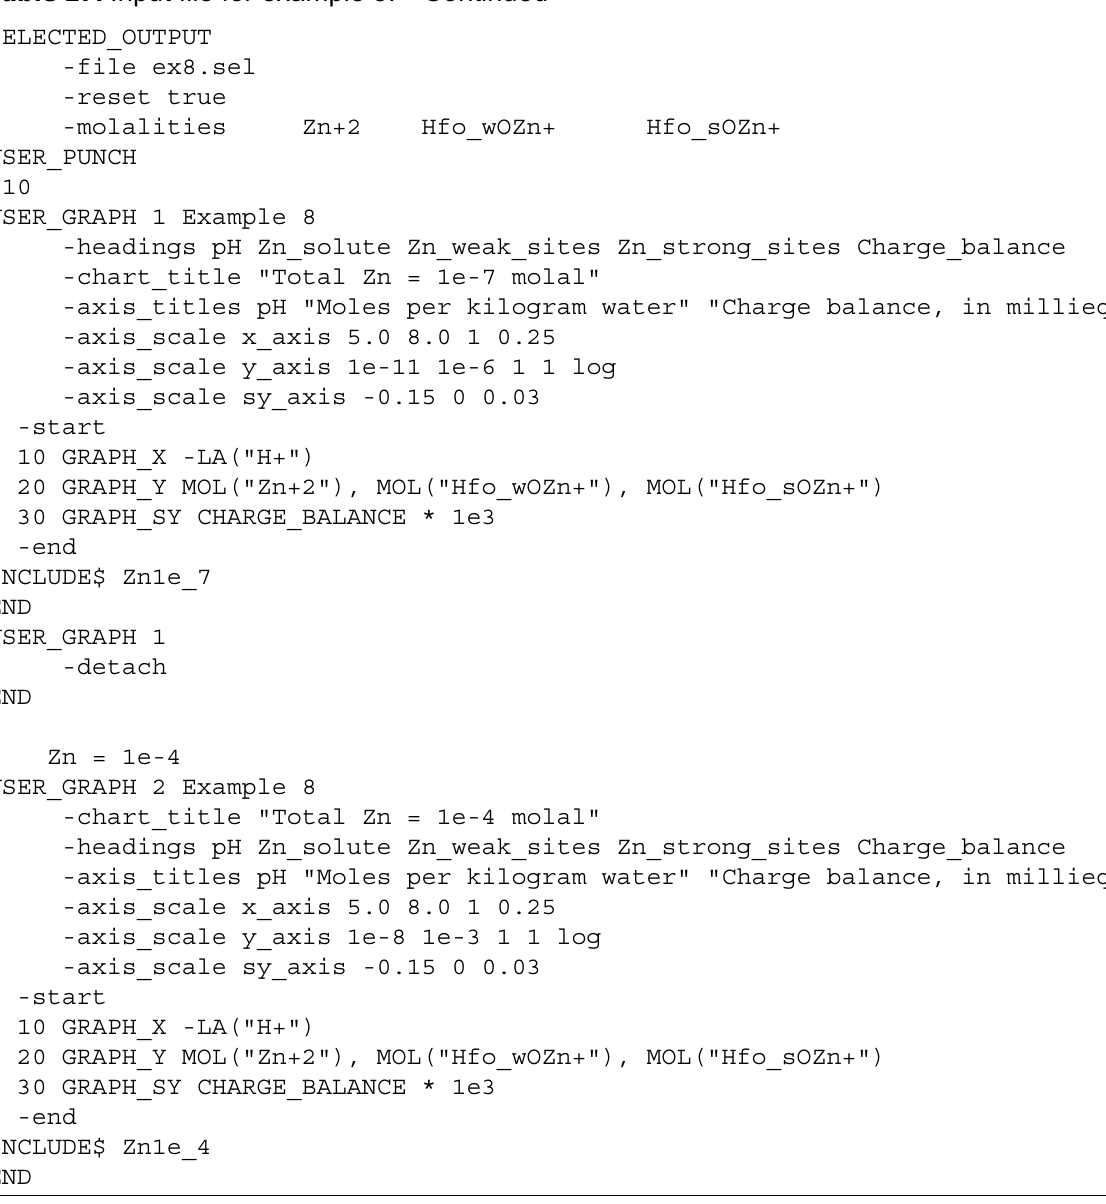
Table 27. Input file for example